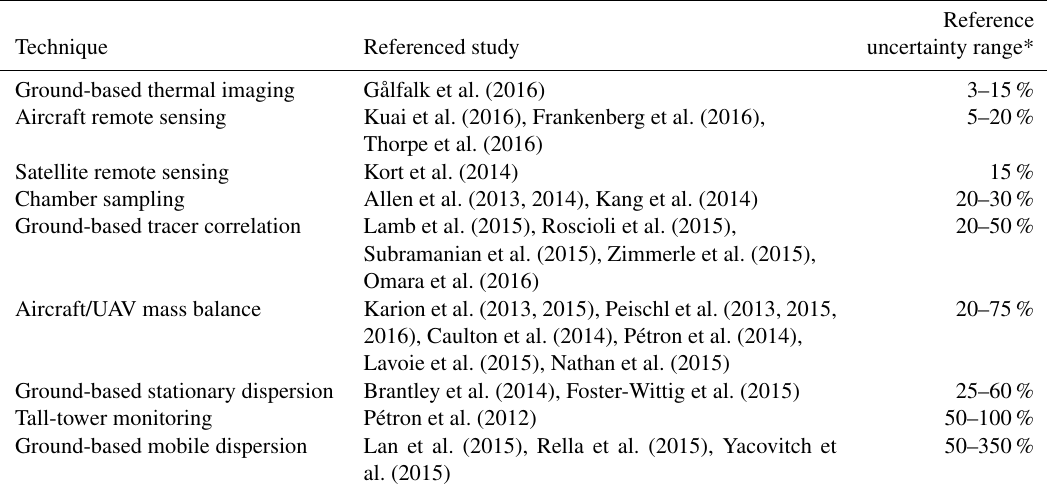
Table 1. Comparison of CH 4 emission measurement techniques and reported